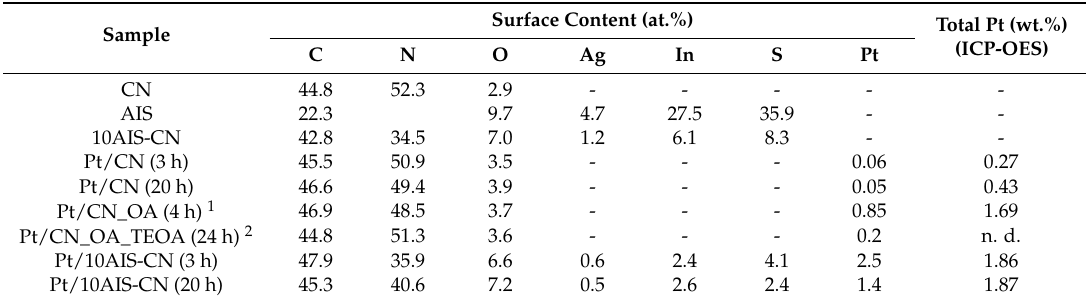
Table 1. Surface composition derived by